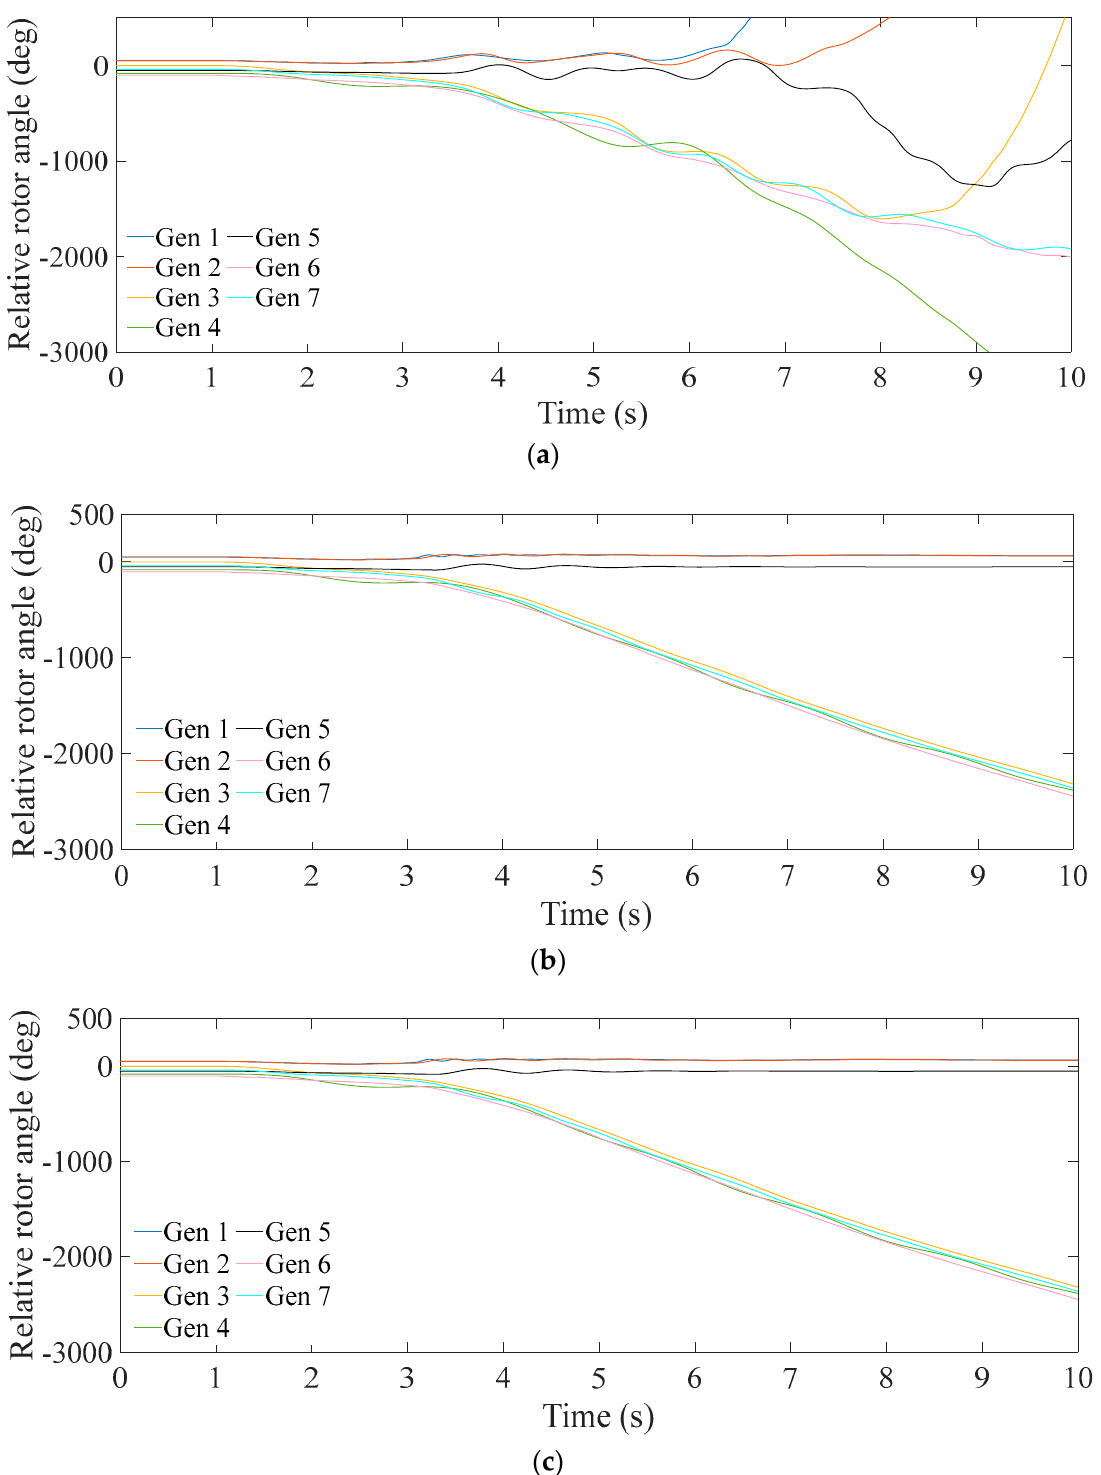
Figure 11. The RRA of a set of generators in Contingency 3 : ( a ) Case 1, ( b ) Case 2, and ( c ) Case 3.